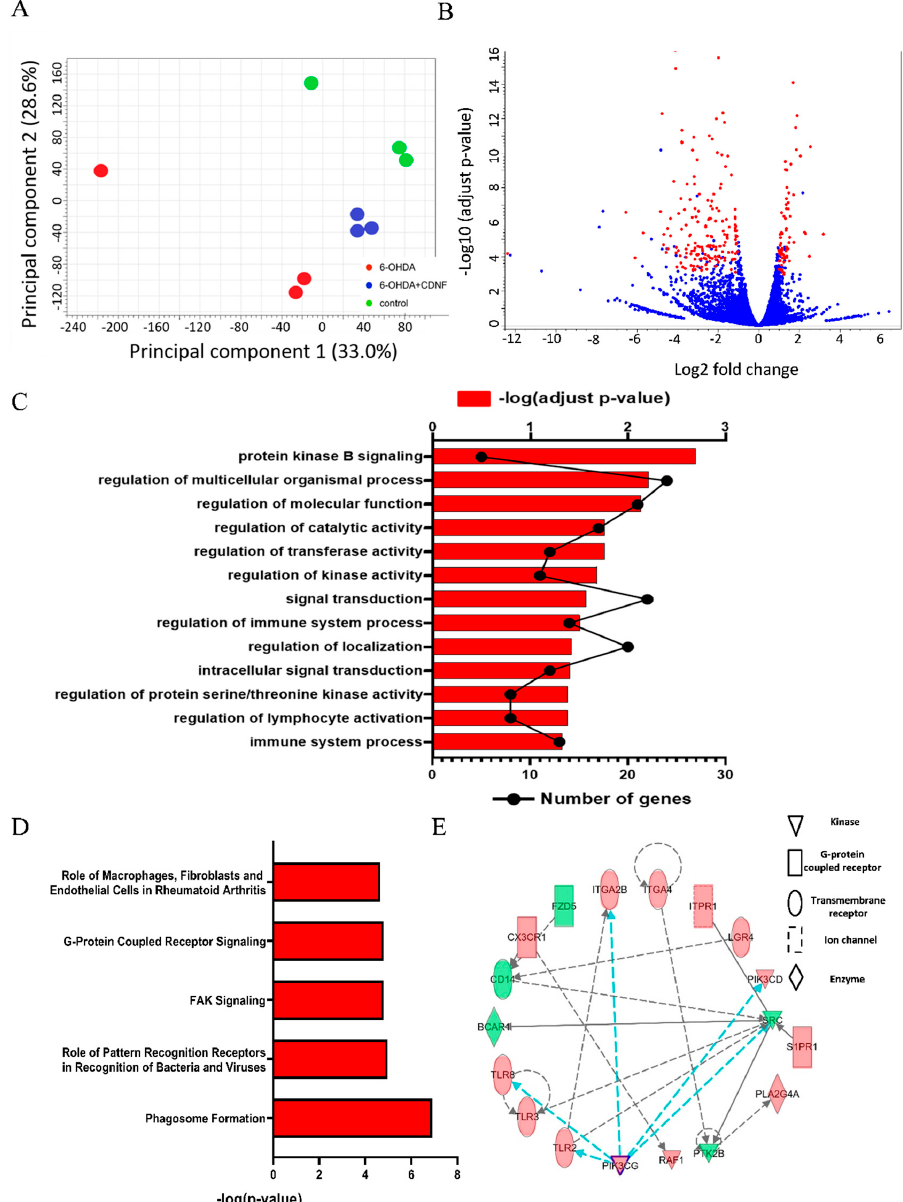
Figure 10. CDNF treatment regulates gene expression in the 6 − OHDA − stimulated BV2 microglial cells. ( A ) Principal component analysis (PCA) of the transcriptomes among control, 6 − OHDA, and 6 − OHDA + rhCDNF groups. ( B ) Volcano plot comparing the log2fold changes and adjusted p -values of 21,860 gene expressions. The red dots indicate genes significantly regulated (log2fold change >1 or < − 1 adjusted p -value < 0.001), and the blue dots indicate genes with no significant change between 6 − OHDA and 6 − OHDA + rhCDNF. ( C ) GO biological processes overrepresentation analysis based on 253 DEGs. ( D ) Ingenuity ® Bioinformatics pathway analysis revealed that highly canonical pathways were differentially expressed in PBS − treated and rhCDNF − treated BV2 cell lines in response to 6 − OHDA stimulation. The canonical pathways included in this analysis are shown along the y -axis of the bar chart. The x − axis indicates the statistical significance. Calculated using the right-tailed Fisher exact test, the p − value indicates which biologic annotations are significantly associated with the input molecules relative to all functionally characterized mammalian molecules. ( E ) The activity of highly connected positive regulators of the inflammatory genes PI3KCG, PI3KCD, TLR2, and TLR8 led to the activation of this phagosome formation network, as assessed using the IPA molecule activity predictor in rhCDNF − treated BV2 cells after 24 h 6 − OHDA